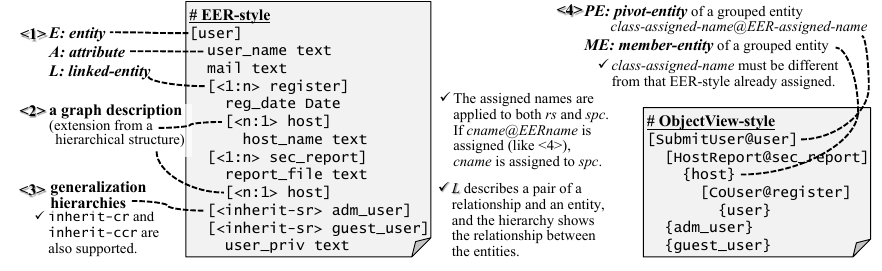
Figure 5: DBPowder-mdl [1].